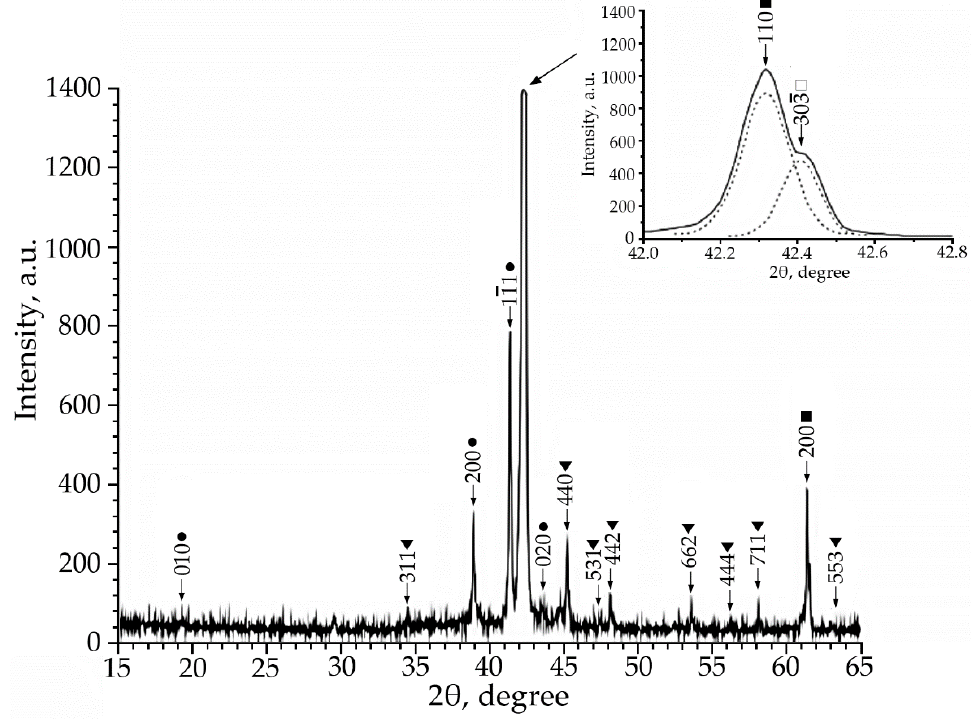
Figure 2. X-ray patterns ( Cu Kα radiation) from alloy No. 2, where: •—martensitic phase В19′ ; ■ —B2-phase; ▼ — Ti 2 Ni secondary phase; — R-phase.